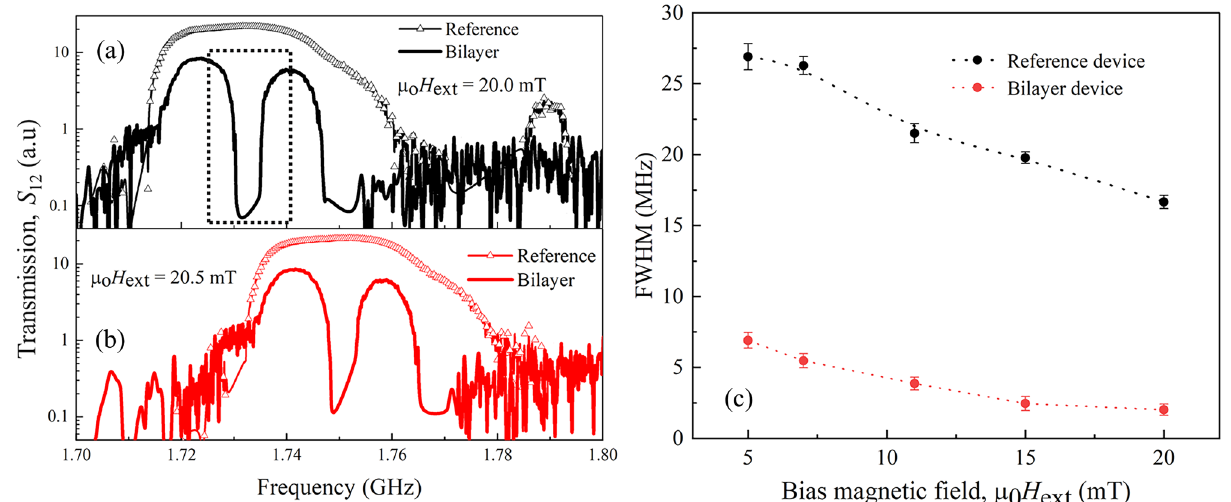
Figure 2. ( a ) S 12 spectra of the reference device (black curve with open black triangle) and bilayer sensor (black curve) at μ 0 H ext = 20 mT. ( b ) S 12 spectra of the reference device (red curve with open red triangle circle) and bilayer sensor (red curve) at μ 0 H ext = 20.5 mT. ( c ) The FWHM of the transmission spectra of the reference device (black dotted curve with filled circle) and the FWHM of the rejection band of the bilayer sensor (red dotted curve with filled circle). We calculated the FWHM and standard deviation ( σ) by Gaussian fitting. We considered ± 3 σ as the error